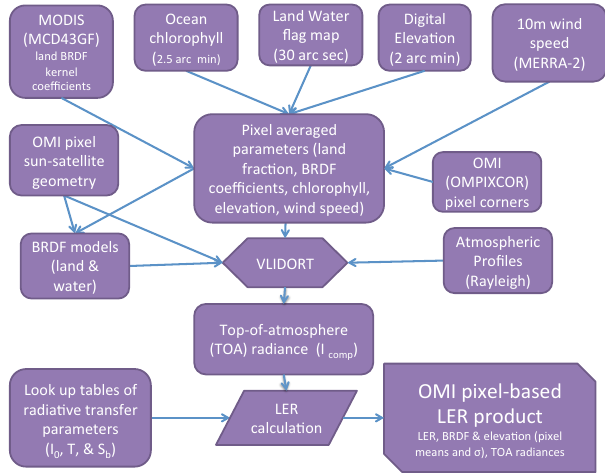
Figure 2. Data flow diagram of generating the geometry-dependent